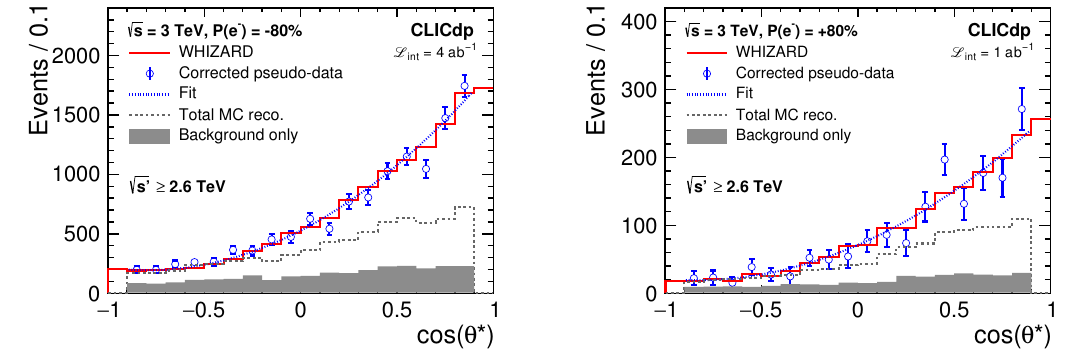
Figure 22. Top-quark polar angle distributions from the analysis of boosted semi-leptonic tt events, at a nominal collision energy of 3 TeV for P (e (cid:0) ) = -80% (left) and P (e (cid:0) ) = +80% (right), and an integrated luminosity of 4 : 0 ab (cid:0) 1 and 1 : 0 ab (cid:0) 1 , respectively. See further details in (cid:12)gure 21.